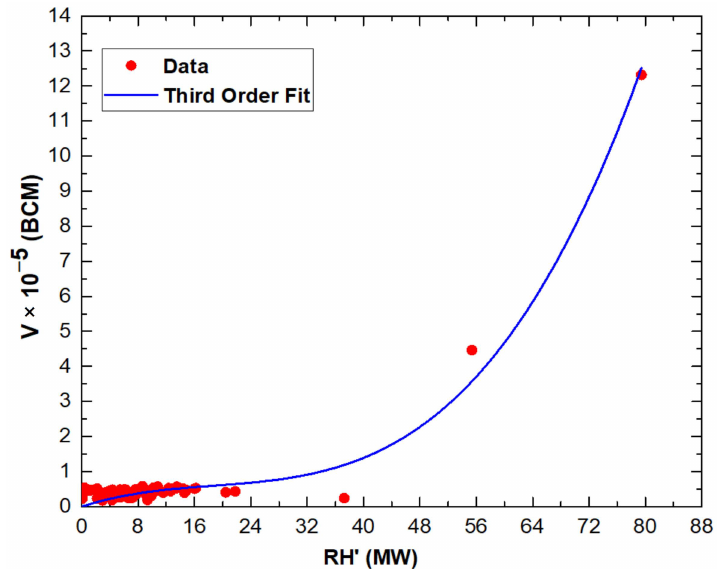
Figure 10. The established intercepting zero “third-order” polynomial regression model, using all October and November 2021 days, by means of the proposed unmixing approach and the provided “hourly” in situ measured flared gas